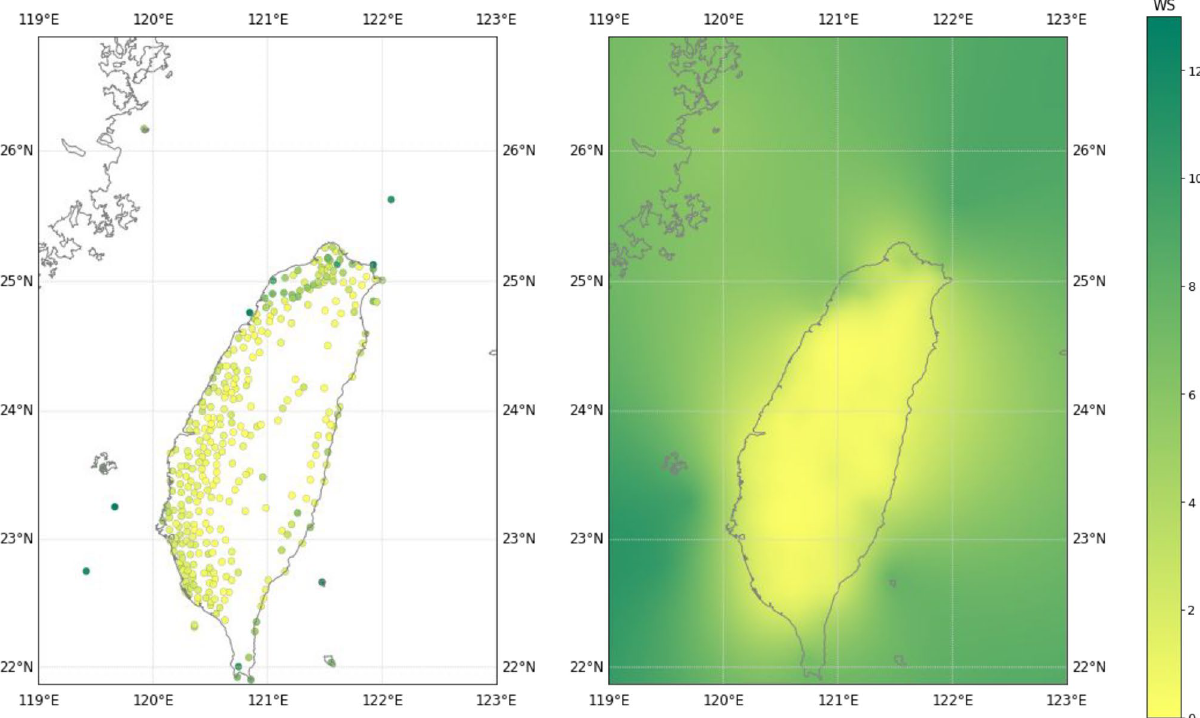
Figure 1. Left side: CWB and buoy monitoring stations. Right side: distribution of ocean wind dataset after kriging